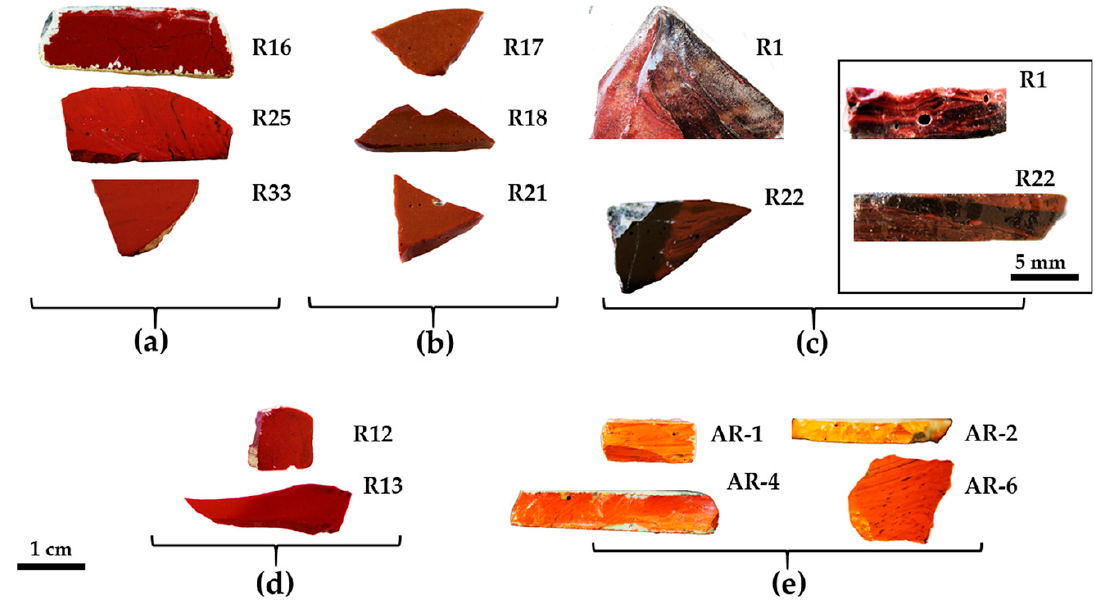
Figure 2. Samples of red sectilia from the Gorga collection: ( a ) Gr-1; ( b ) Gr-2; ( c ) Gr-3; ( d ) Gr-4; ( e ) Gr-5.